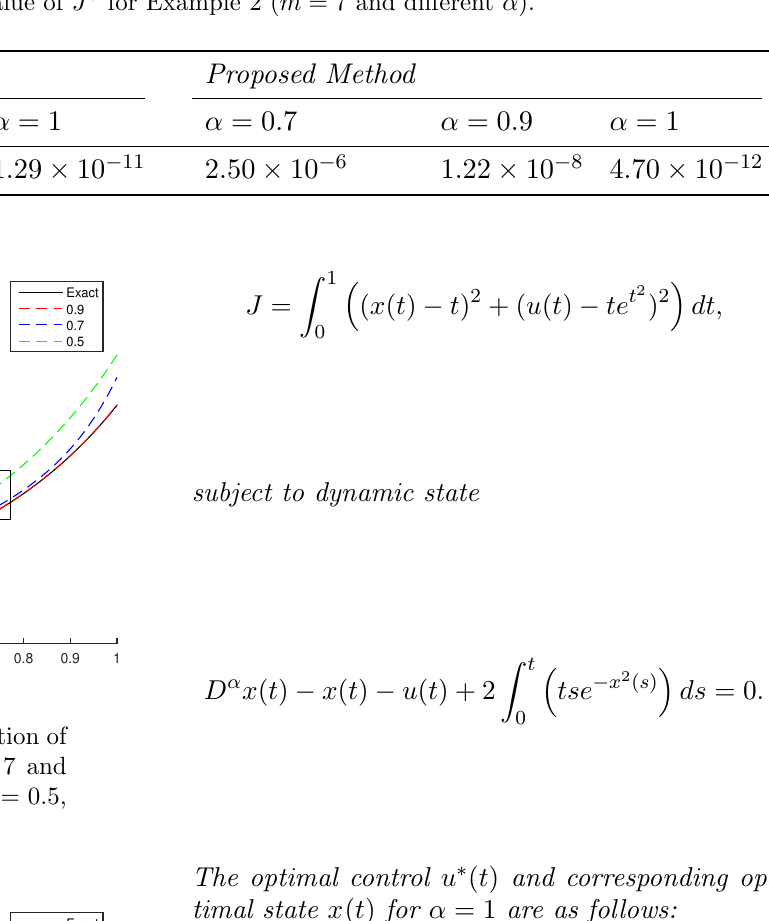
Table 2. The value of J ∗ for Example 2 ( m = 7 and different α ).